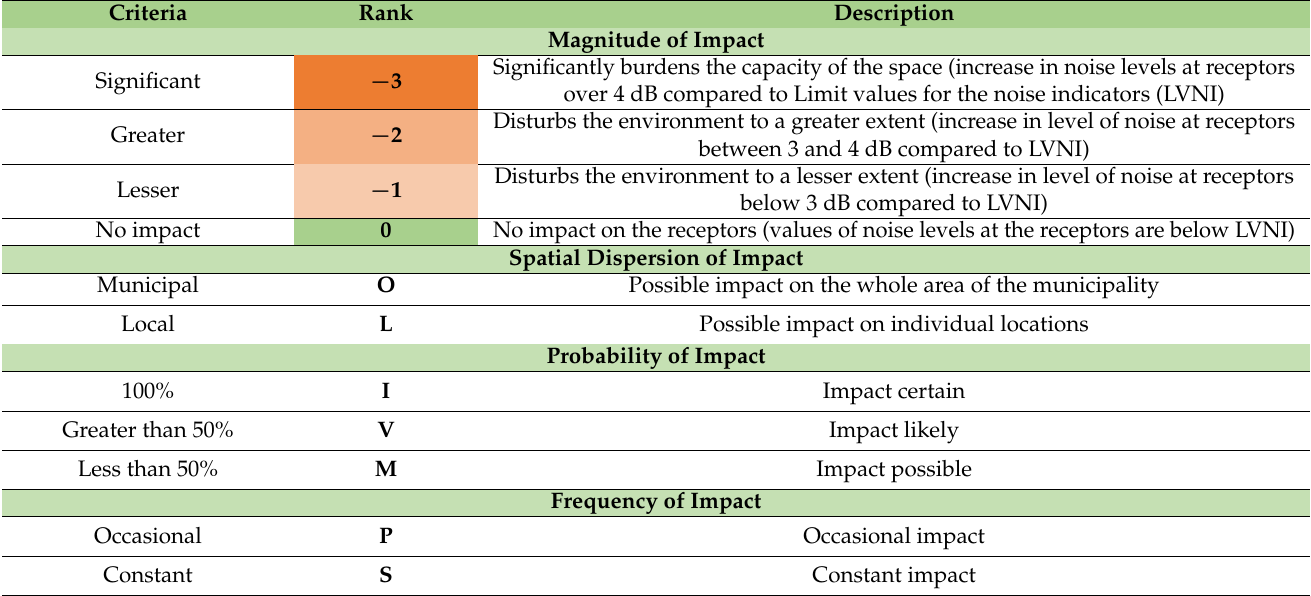
Table 2. Excerpt from the table “Quantitative and qualitative SEA criteria for the evaluation of noise impact”. (Source: SEA for the Urban Plan of the Maestrale Ring wind